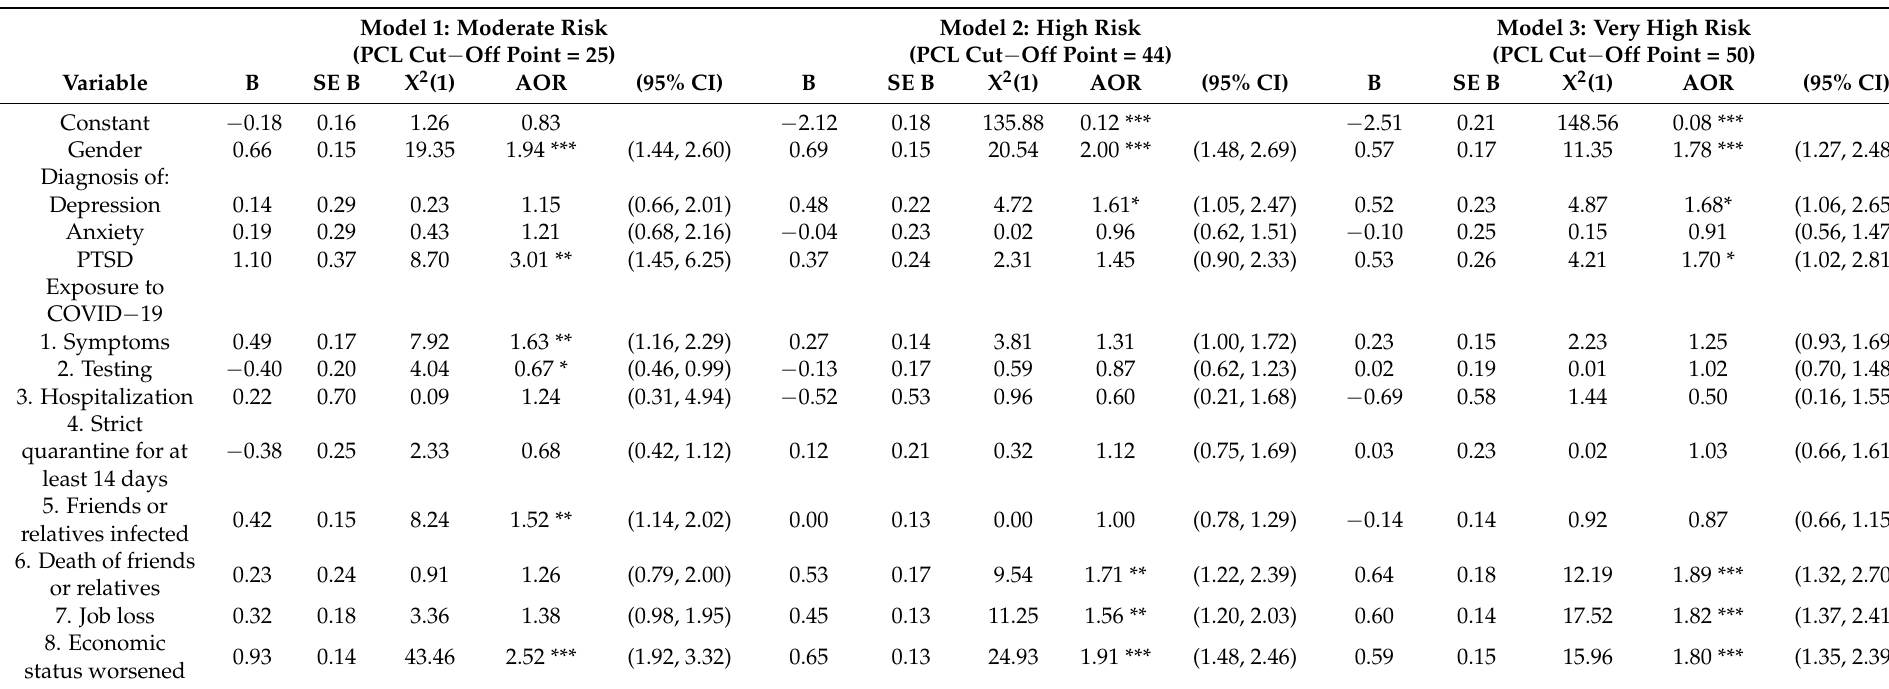
Table 5. Results of logistic regression for coronavirus-related PTSD risk among university students during the second wave of the COVID-19 pandemic (W2) ( N = 1741). Model 1: Moderate Risk Model 2: High